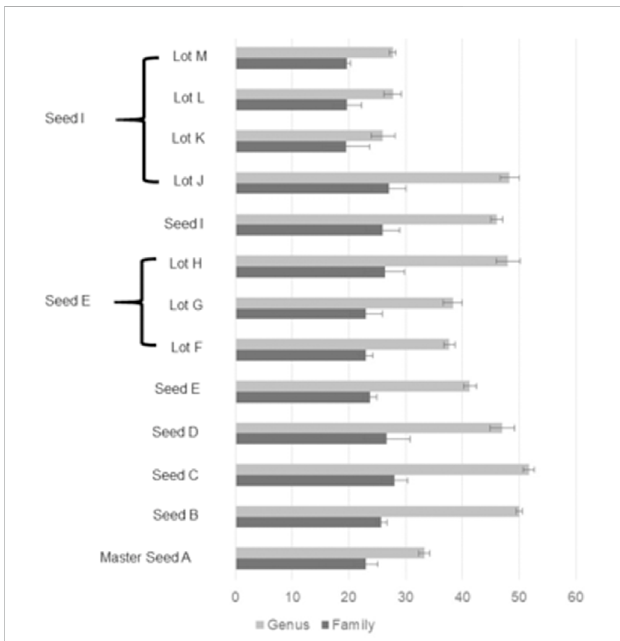
Number of different taxa in 16S rRNA sequences from master seed A, seed stocks (B – E, I) and commercial lots (F – H, J – M) at family (90% similarity) and genus (95% similarity) level. The error bars estimate sequence analysis error detected by sequencing the same sample three